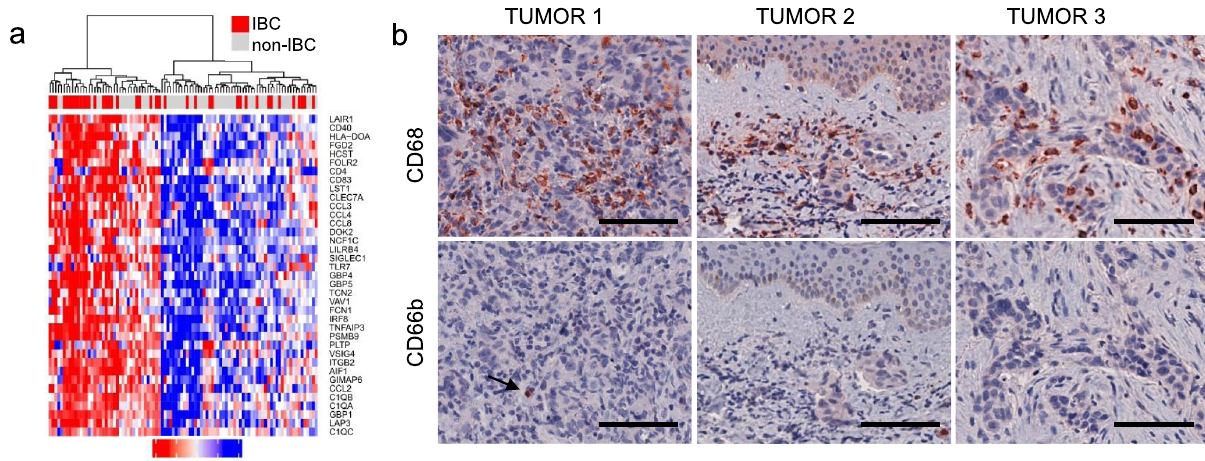
Fig. 10 Macrophages and neutrophils in human IBC. a Hierarchical clustering of human IBCs and non-IBCs based on expression of genes characteristic for tumor-associated macrophages (TAMs) in breast cancer. TAM-speci fi c 37-gene signature 30 was applied to microarray data from human IBCs ( n = 41) and non-IBCs ( n = 55) 24 . Percentile rank of gcrma normalized microarray signal intensities was z -score transformed and z -scores are shown. b Human IBC samples immunostained with antibodies against CD68 for macrophages and CD66b for neutrophils, as indicated. Images shown are representative of n = 9 tumors with different clinical presentations of IBC: IBC presenting as a solid tumor (tumor 1), as a lymphovascular emboli (tumor 2) or with highly diffuse pattern of growth (tumor 3). Scale bars: 100 μ